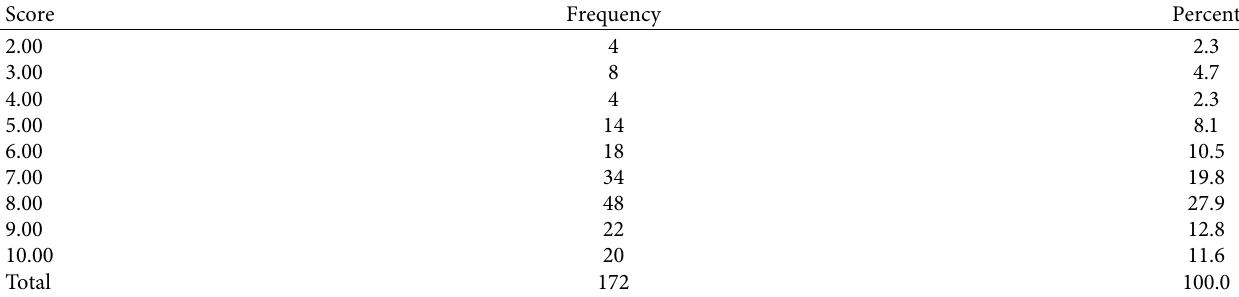
Table 3: Extent to which leaderships skills are applied in steering fibre optic infrastructure.